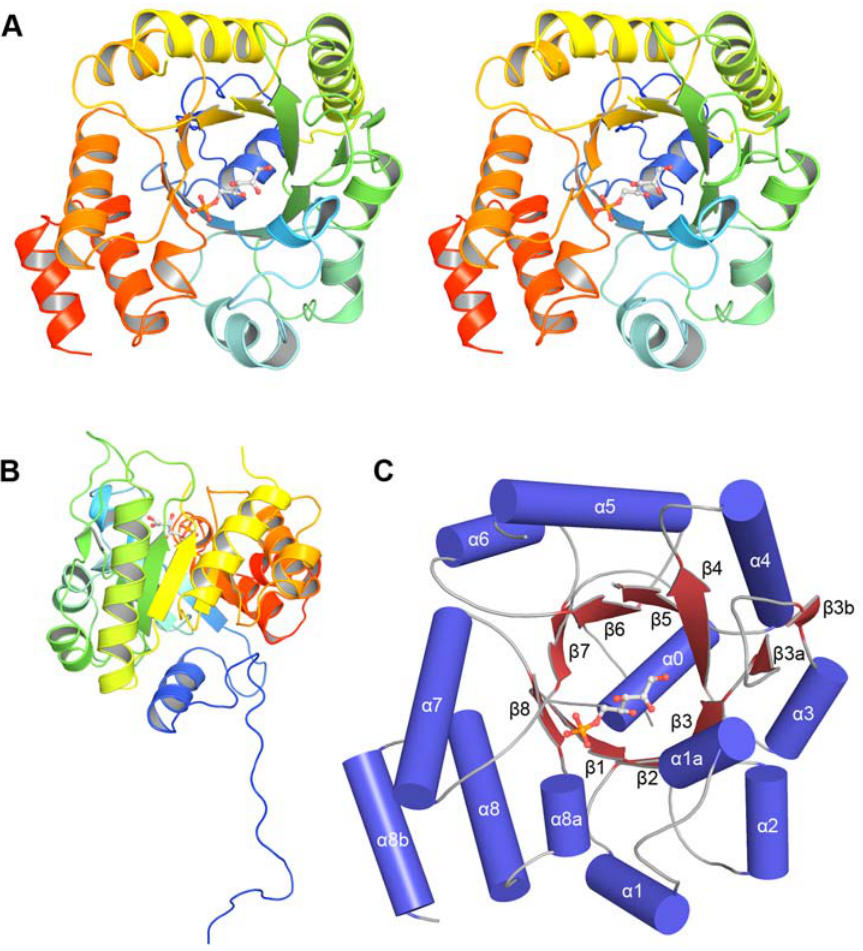
Figure 2. Structure of a single LsrF chain. A. Stereoview of a single ( a / b )8-barrel subunit with protein backbone in cartoon representation and bound P-AI-2 analogue (ribulose-5-phosphate) as ball-and-stick. The protein backbone is rainbow colored, with blue at the N-terminus and red at the C-terminus. B. Rotated view of the subunit (approximately 90 u ) highlighting the N-terminal residues that extend away from the ( ab )8-barrel and are swapped with the adjacent 2-fold related subunit. C. Identification of the components of the ( ab )8-barrel, with a -helices as blue cylinders and b -sheets as red arrows. The bound ligand (ribulose-5-phosphate) is shown in ball-and-stick format.